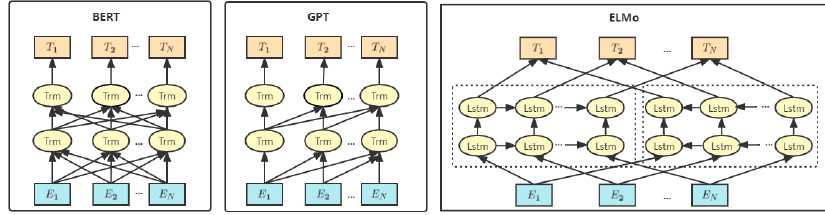
Figure 4. Illustration of pre-trained language models (Redrawn from